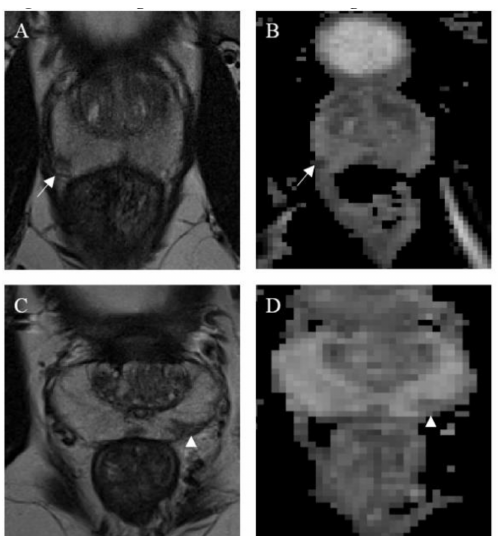
Figure 2. Magnetic resonance images from a clinically significant ( A , B ) and a non-clinically significant ( C , D ) prostate cancer lesion. Both are located in the peripheral zone; the clinically significant lesion, found in the right middle-posterior location (white arrows), appears as a nodular and well-defined area of low signal on both T2w ( A ) and ADC map ( B ). Conversely, the non-clinically significant lesion, found in the left middle-posterior location (white arrow heads), appears wedge-shaped, with no bulging on T2w ( C ) and only is mildly hypointense on the ADC map ( D ). Both lesions were deemed worthy of targeted